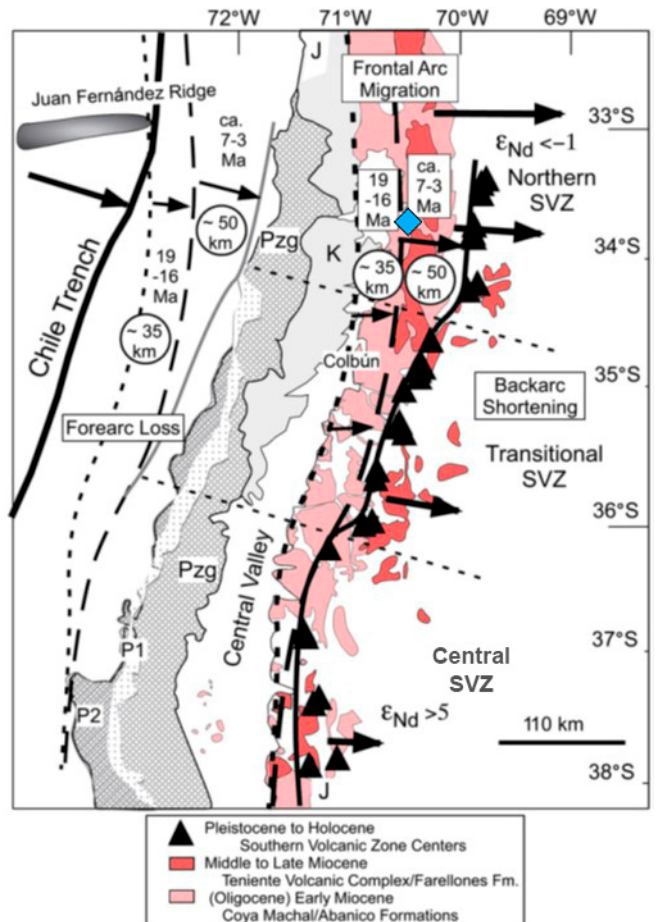
Figure 3. Regional map of central Chile between ~32° S and 38° S, with lines showing correlations of early Miocene to Holocene arc fronts on land and inferred position of corresponding coastlines offshore [10]. Arrows show relative amounts of frontal-arc migration, forearc loss, and backarc shortening. Northwest–southeast trending dashed lines show offsets in the modern volcanic front that separate the Southern Volcanic Zone (SVZ) into the northern, transitional, and central segments [4]. In the active arc region, lines connect outcrop patterns marking early Miocene (pink), middle to late Miocene (red), and the Pleistocene to Holocene volcanic centers of the SVZ (triangles) magmatic fronts. Arrows between the lines indicate inferred distance (given in circles) of frontal-arc migration from 19 to 16 Ma and from 7 to 3 Ma. In the forearc, lines between the trench and the coast show inferred early Miocene (short dashed) and middle to late Miocene (long dashed) coastlines under the assumption that the distance of frontal-arc migration equals the width of missing coast. Arrows between the lines in this region indicate distance (shown in circles) of inferred loss by subduction erosion from ca. 19 to 16 Ma. and 7 to 3 Ma. In the backarc, the length and position of arrows show the location and proportional amounts of crustal shortening over the past 20 m.y. inferred from structural profiles. Also shown are other outcrop patterns that have long been used as evidence for forearc subduction erosion along this margin [6]. The first is the northward narrowing and disappearance of the Paleozoic high pressure (P1) and low pressure (P2) paired metamorphic and granitoid (Pzg) belts along the coast. The second is the presence of Jurassic arc rocks (marked by J) along the coast north of 33 ◦ S, but inland near the SVZ at ~38 ◦ S. K indicates Cretaceous magmatic rocks. ε Nd is + 5 for active SVZ volcanoes south of 36 ◦ S, and ≤− 1 for those in the northern SVZ north of 34 ◦ S, as a result of increased mantle source region contamination by subducted crust due to the northward increase in the rate of subduction erosion associated with the subduction of the Juan Fern á ndez Ridge at 33 ◦ S [3–5]. El Teniente occurs at the blue diamond. (Reprinted from Geologic Society of American Bulletin, volume 117, Kay, S.M. et al., Episodic arc magmatism, crustal thickening, subduction erosion, and magmatism in the south-central Andes, page 83, Copyright 2005, with fair use permission from the Geologic Society of